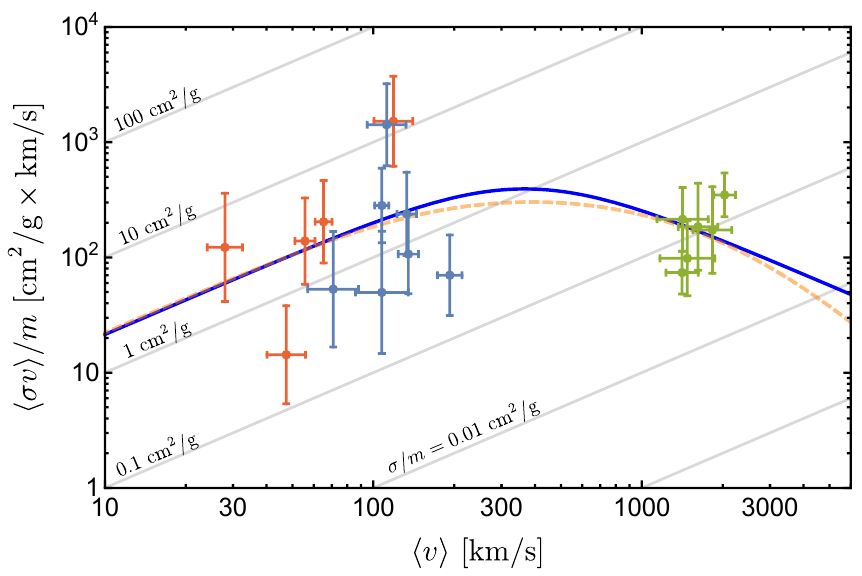
Figure 1 . Self-interaction reaction rate h v (cid:27) elastic i for dark matter particles as a function of the mean velocity h v i . The data points are results from Kaplinghat, Tulin, and Yu for dwarf galaxies (red), low-surface-brightness galaxies (blue), and galaxy clusters (green) [53]. The curves are the best (cid:12)t for a dark-photon model with (cid:11) 0 = 1 = 137 [53] (dashed) and the best (cid:12)t to eq. (2.5) (solid). The diagonal lines are for energy-independent cross